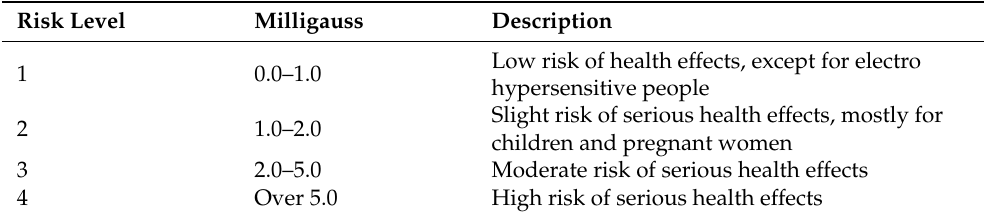
Table 1. Low frequency magnetic guidelines for continuous and prolonged exposure [16]. Risk Level